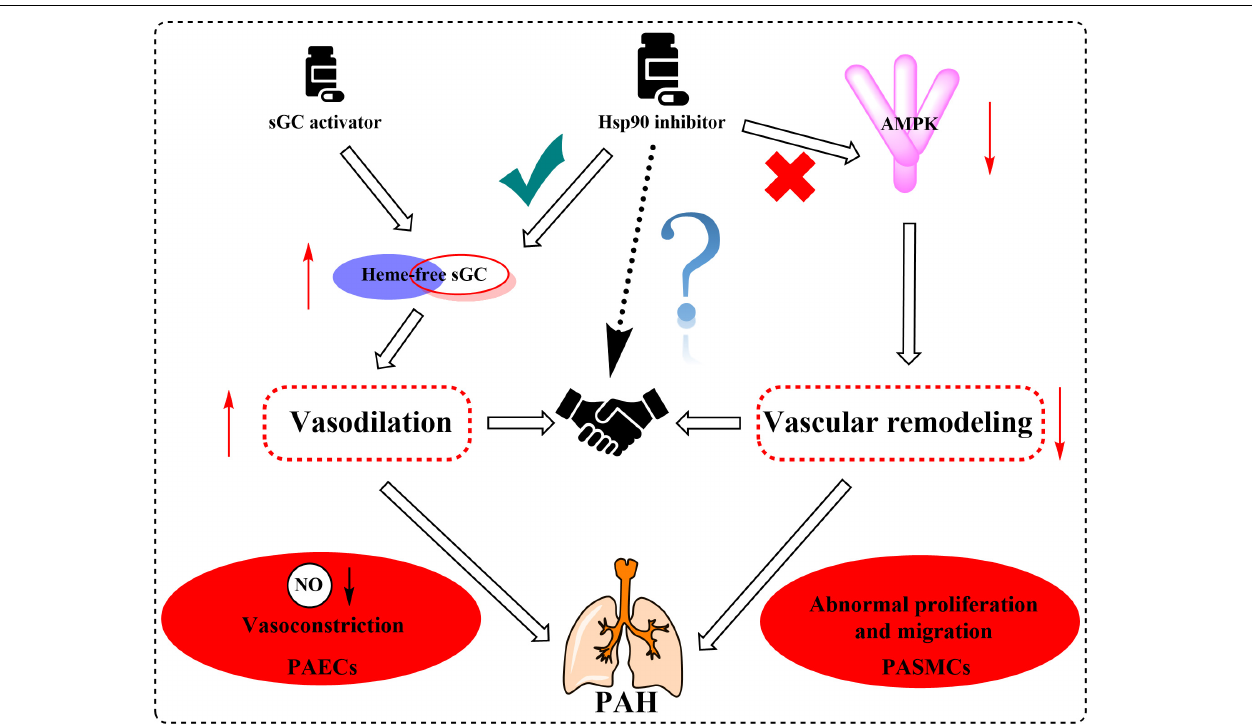
FIGURE 5 | Proposed mechanism graph shows that the combination of Hsp90 inhibitors and sGC activators may lead to better treatment of PAH via relaxing blood vessels and inhibiting vascular